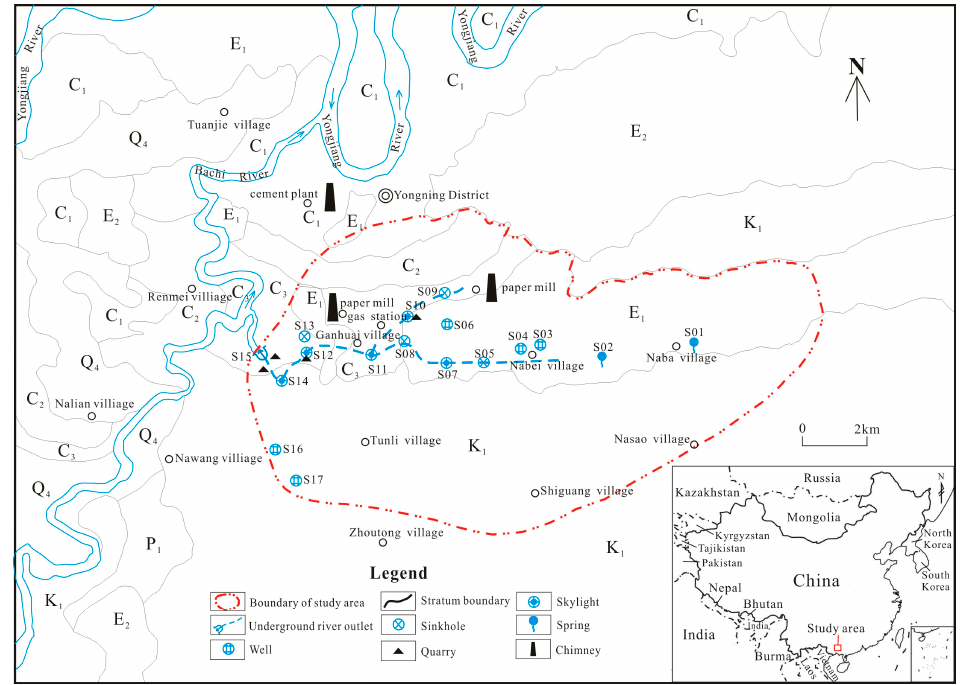
Figure 1. Location map showing sampling points in the study area, and regional distribution of geological